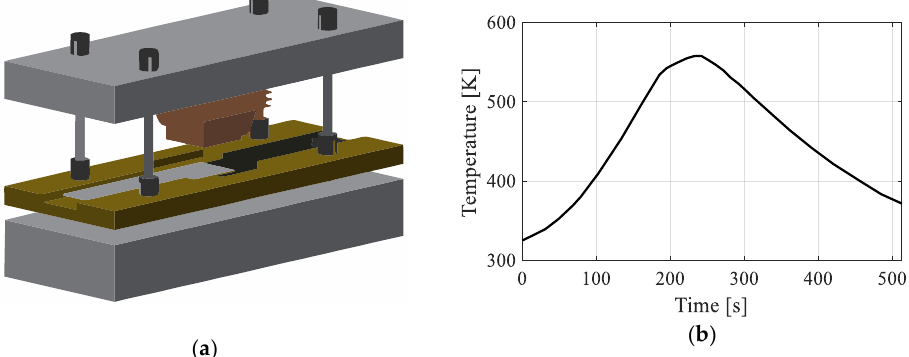
Figure 4. Joining fixture and temperature profile. ( a ) Apparatus with a heatable die for the production of tensile shear specimens. ( b ) Temperature inside the joining zone during the hot pressing process. of tensile shear specimens; ( b ) Temperature inside the joining zone during the hot pressing